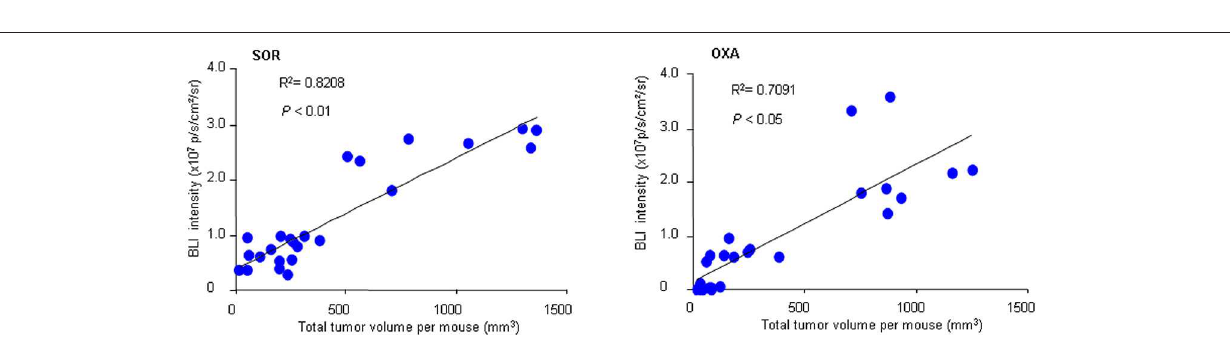
FIGURE 5 | Correlation between BLI intensity and total tumor volume. At the end of sorafenib (SOR) or oxaliplatin (OXA) treatment, the in vivo BLI intensity and the total tumor volume for each mouse were calculated ( n = 24). A correlation analysis between tumor volume and BLI intensity was performed using a Pearson correlation